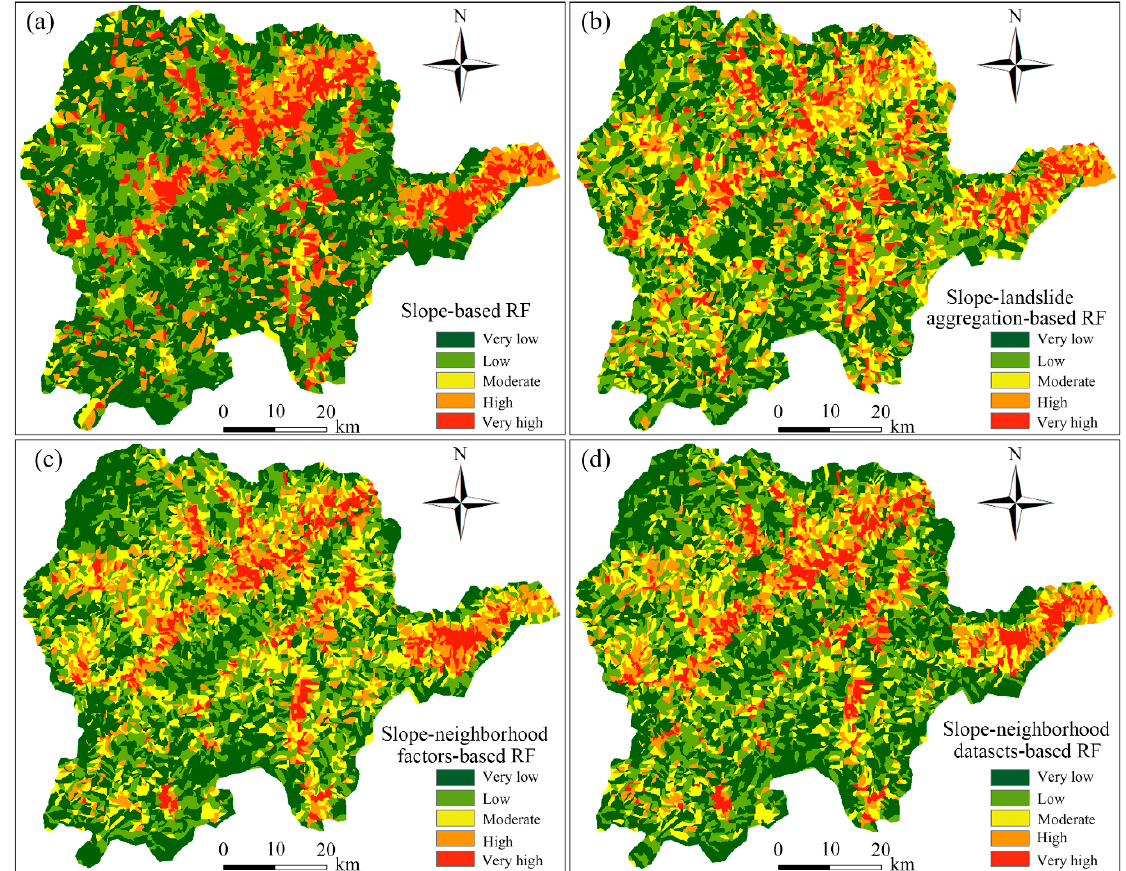
Figure 8. LSP under different combination conditions based on the RF model. ( a ) Slope-based RF; ( b ) Slope–landslide aggregation-based RF; ( c ) Slope–neighborhood factors-based RF; ( d ) Slope– neighborhood datasets-based RF.